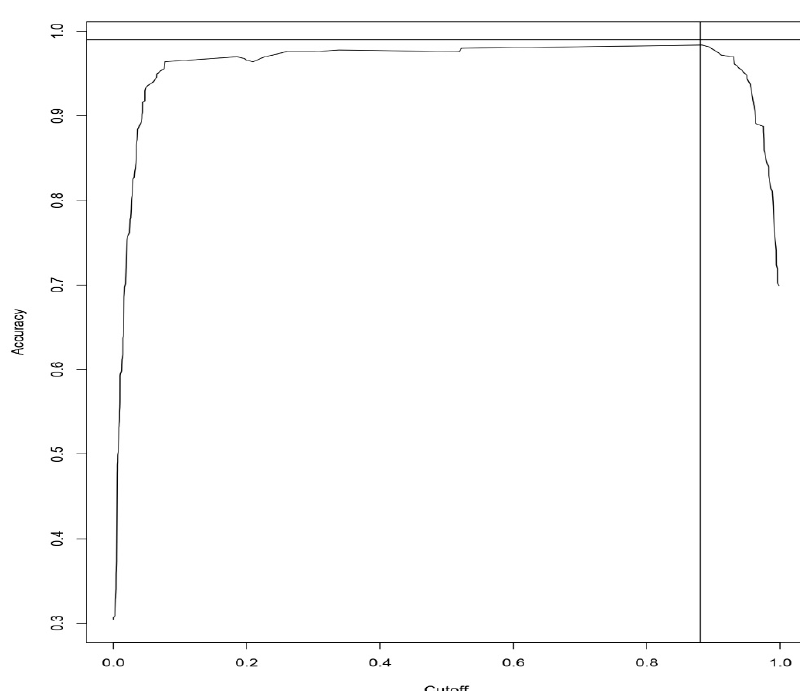
Figure 5. Accuracy Vs. cut-off curve for Random Forest Approach.